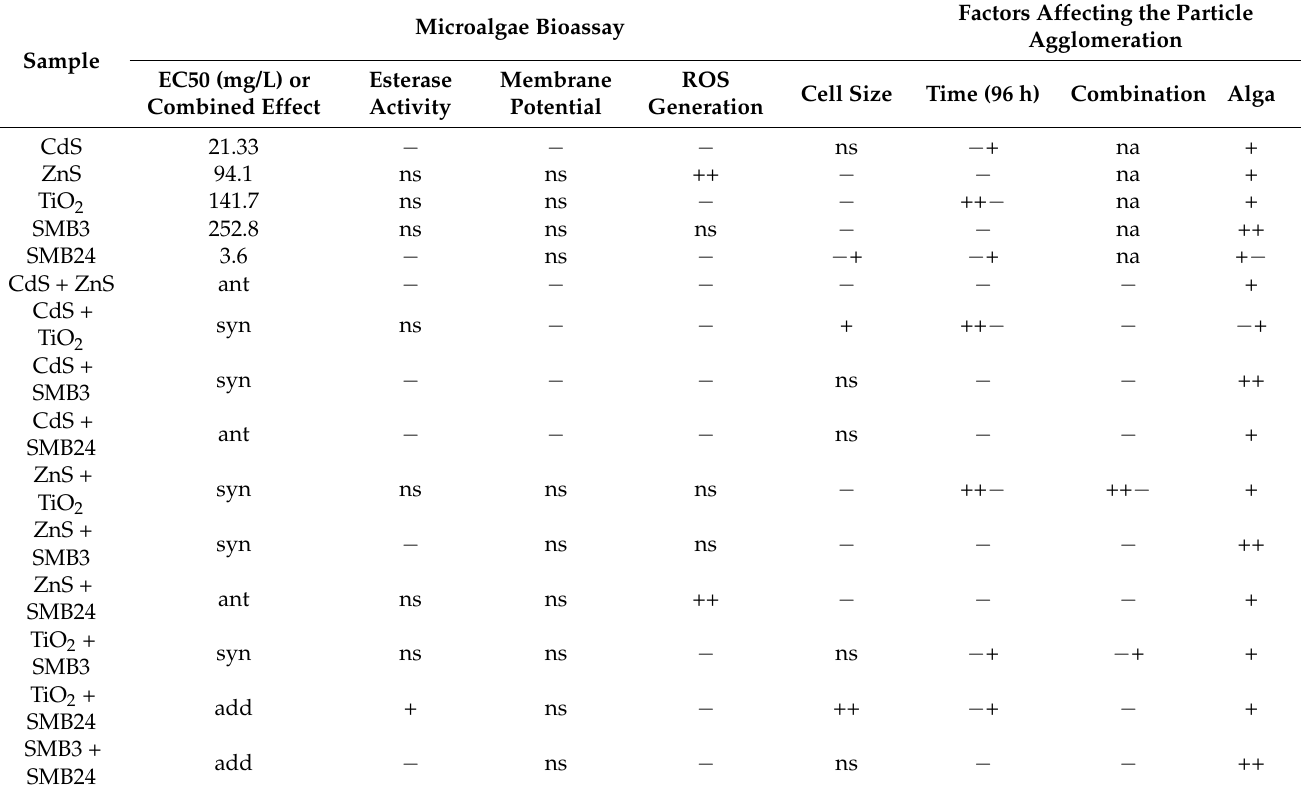
Table 3. The summary of single and binary mixture toxicity assessment and agglomeration of the NPs. Microalgae Bioassay